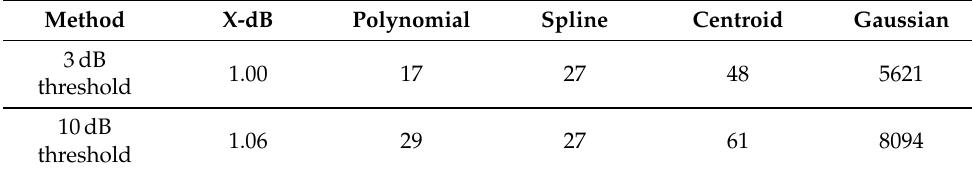
Table 10. Average peak tracking relative time per